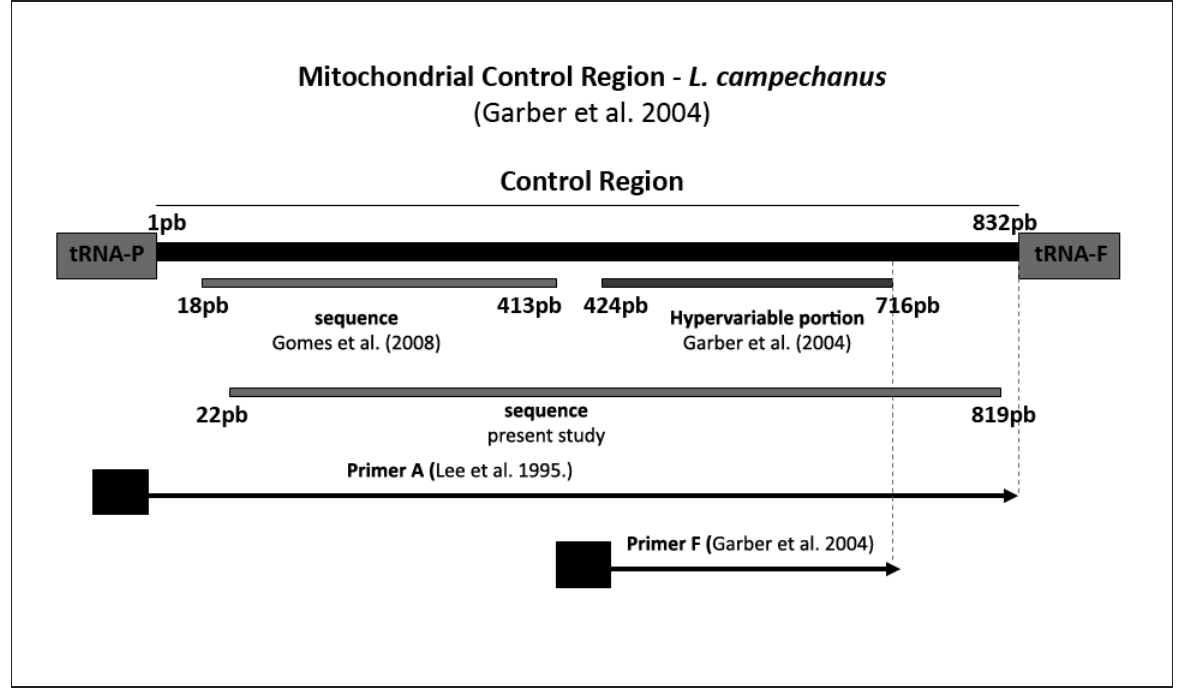
Fig. 2 - Schematic representation of the complete sequence of the mitochondrial control region in L. campechanus , showing the fragments sequenced by Gomes et al. (2008) and Garber et al. (2004), and the primers used in the present